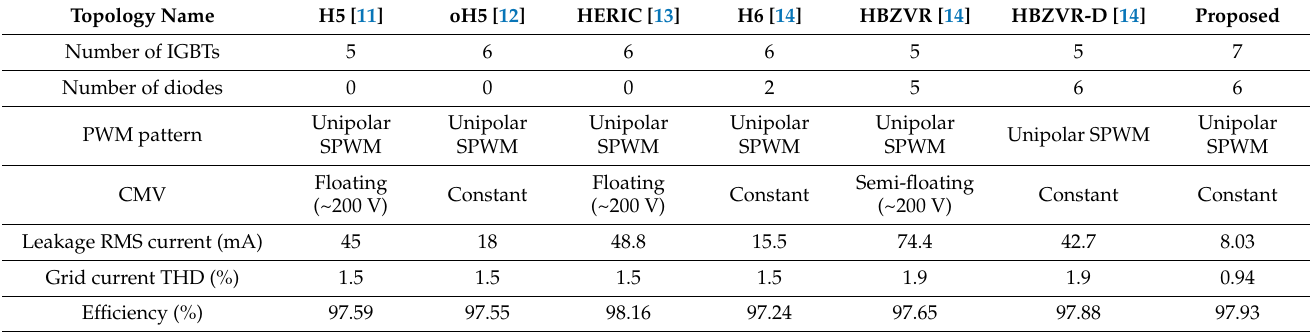
Table 2. Comparison of the proposed transformer-less inverter with existing